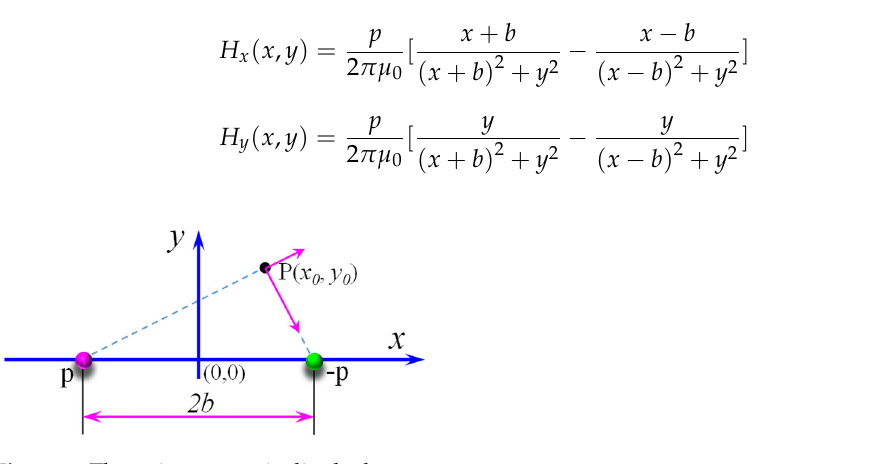
Figure 5. The point magnetic dipole theory.